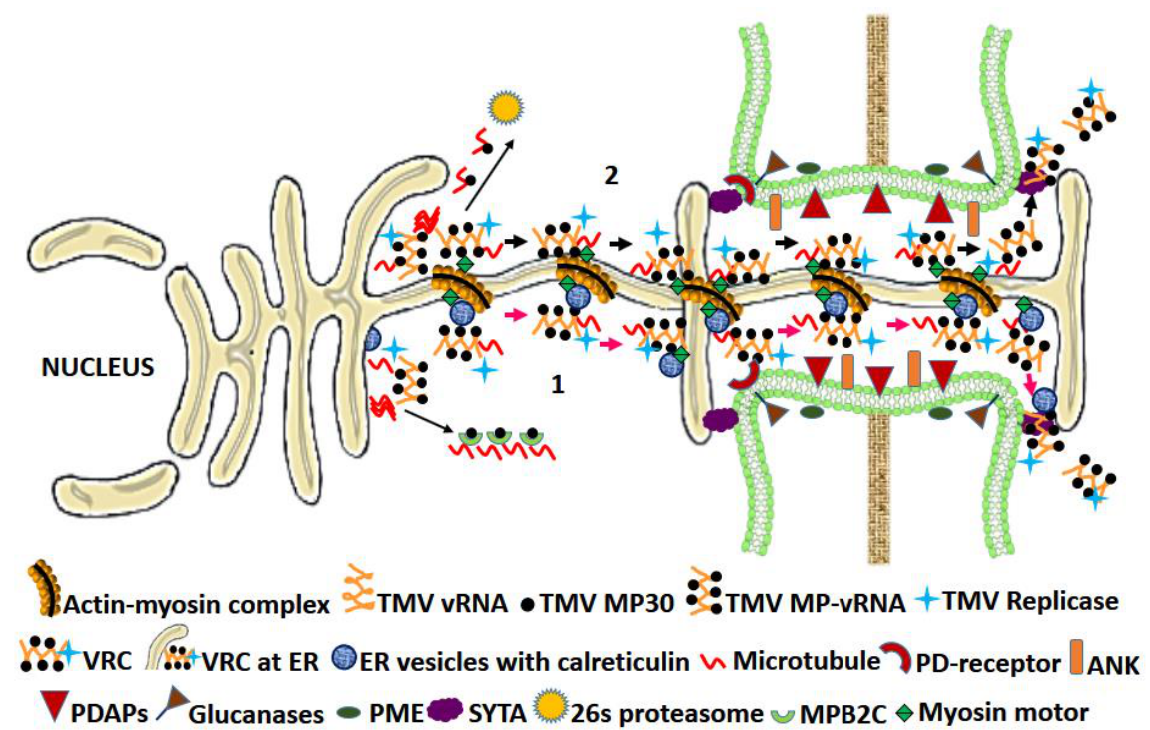
Figure 2. Model for intercellular movement of TMV: The TMV movement protein (MP) at the peripheral endoplasmic reticulum (ER) binds to viral RNA to form a vRNP complex (TMV MP-vRNA), which is joined by replicase to form a VRC. The VRC is delivered to PD either through calreticulin-containing ER-derived vesicle gliding through cell cytoskeleton constituted by the microtubule and ER-actin network (1; red arrows) [8,11] or under the influence of an MP-PLS [32,47,48], the VRC moves along the ER to PD, rafting over cytoskeleton driven by the myosin motor proteins (2; black arrows). Once the VRC reaches the PD, several PDAPs and other viral and host factors cumulatively work for PD “gating” [129]. Gating may occur by MP-mediated severing of actin microfilaments or by recruitment of specific β -1,3-glucanases for callose degradation. Additionally, the MP also interacts with the ANK host factor for downregulating callose. The cell wall-associated PME cause PD targeting of MP and assist gating [36,130]. The MP-PLS is recognized by SYTA, a tethering protein across ER-PM contact sites. These sites are recruited by MP for gating [32,49]. The microtubule near VRC may cause MP degradation via 26 s proteasome [6]. The MPB2C, a microtubule-associated plant factor, causes microtubular accumulation and binds to TMV-MP at the late infection stage to hinder its intercellular movement function [131]. Abbreviations: ANK— ankyrin repeat-containing; MPB2C—movement protein-binding 2C; PDAPs—PD-associated proteins; PLS—plasmodesmata localization signal; PME—pectin methyltransferase; SYTA—synaptotagmin A; VRC—viral replication complex; vRNP—viral ribonucleoprotein.